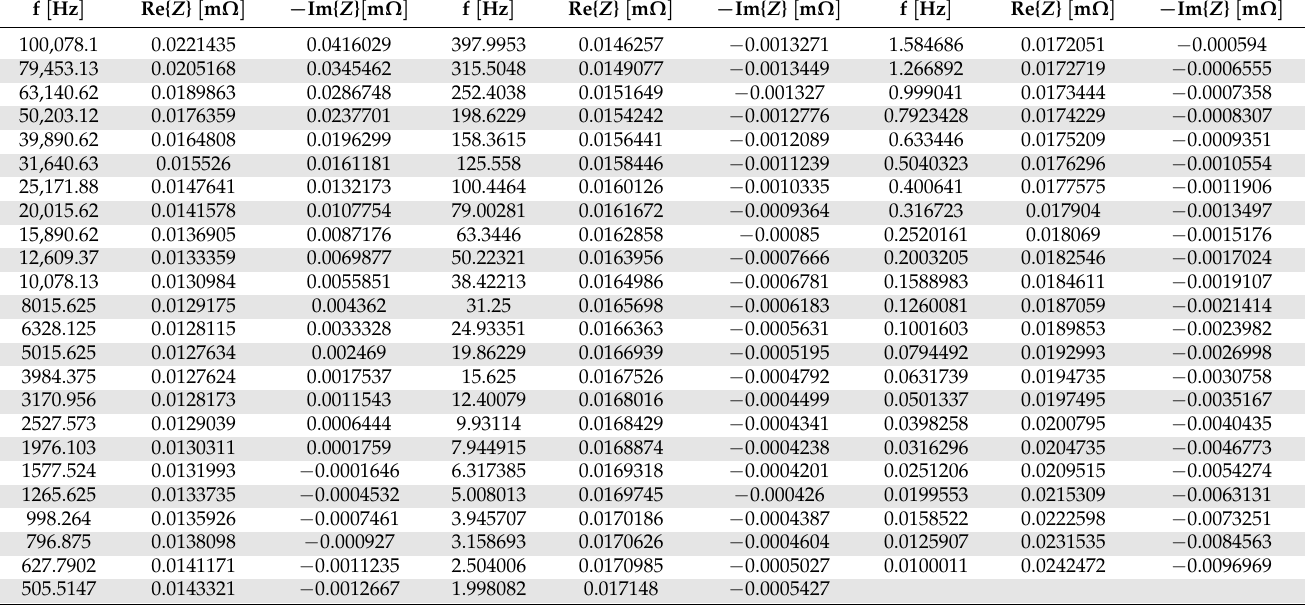
Table A7. EIS data for Samsung 30Q at an SOC of